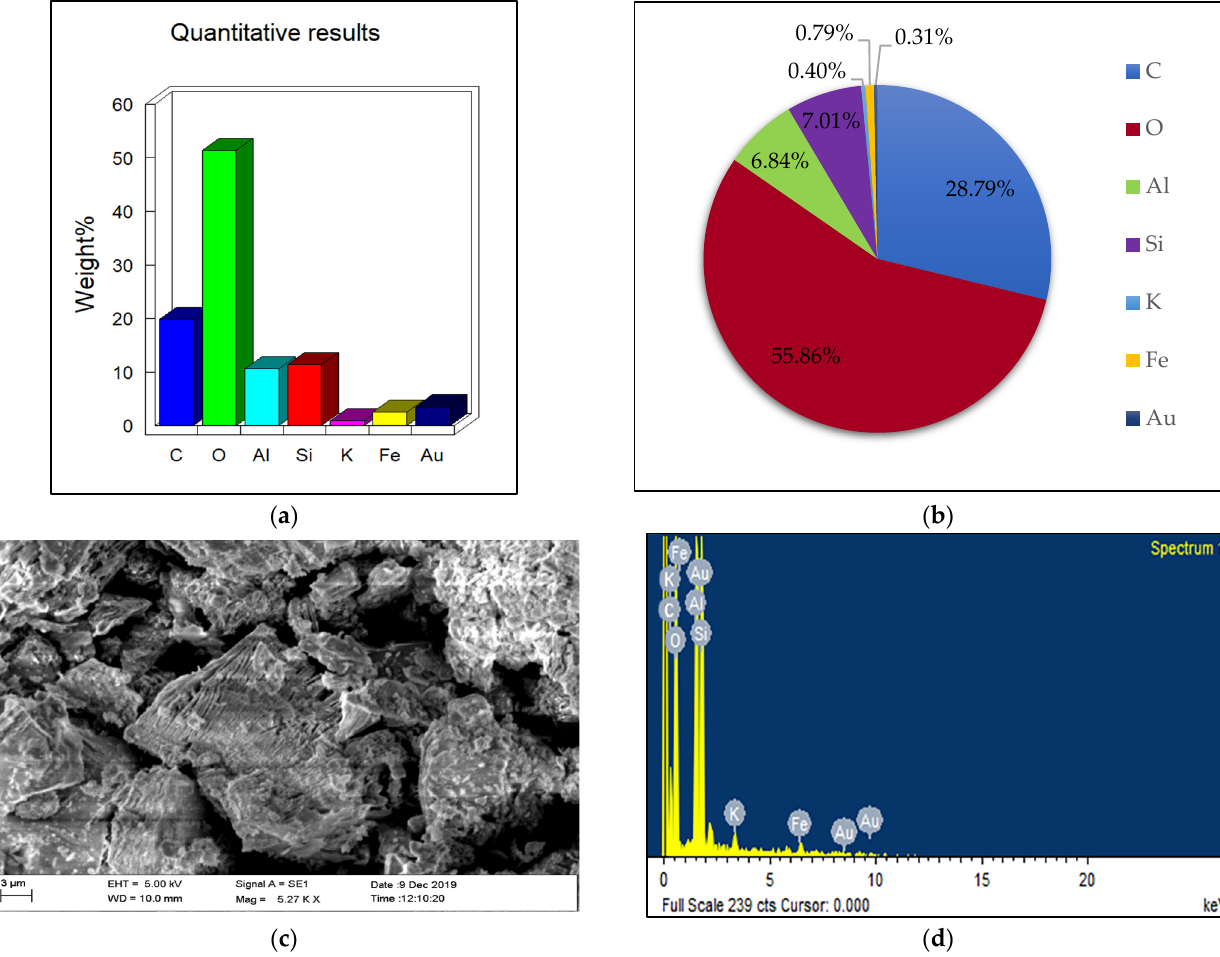
Figure 21. EDS Analysis of Byndoor sample; ( a ) elements weight (%), (b) atomic weight (%), ( c ) SEM image, ( d ) spectrum image.